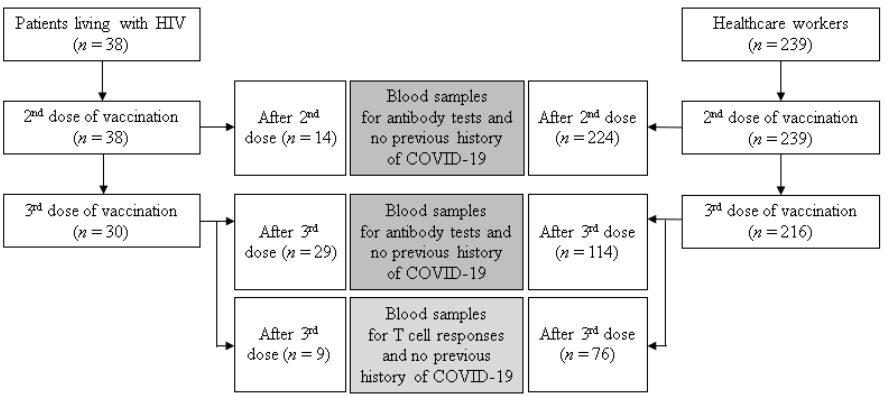
Figure 1. Schematic flow chart of the study.